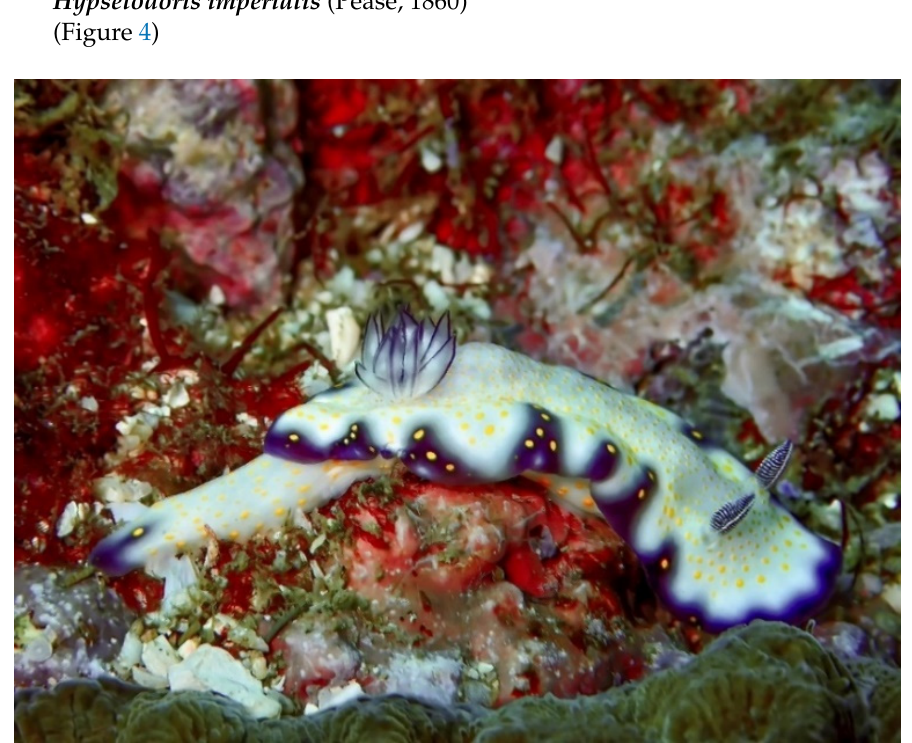
Figure 4. Hypselodoris imperialis , South Solitary Island, NSW, 24 January 2022. Photo: N. Fripp.